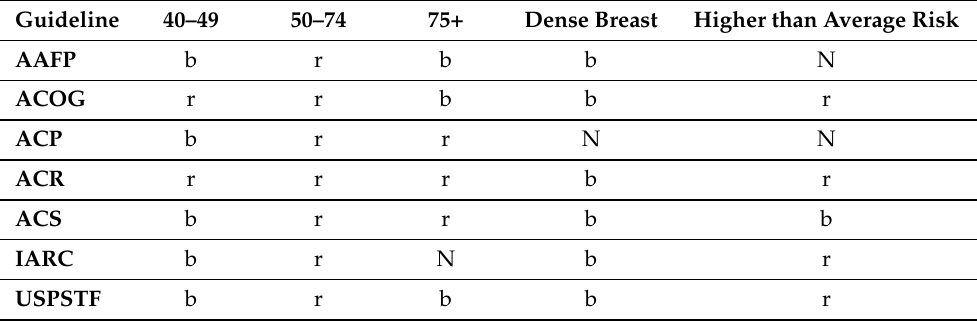
Figure 2. The method of comparing concepts in full documents and recommendations contained in summaries. Note the difference in representations: the document are represented by a large number of high-dimensional (200) vectors with real valued features, whereas the disagreement representations can be low-dimensional vectors with discrete features (e.g., five-dimensional for the breast cancer screening guidelines). Our exposition will roughly follow the left-to-right order of this figure, using the breast cancer screening guidelines as the motivating example. Table 1. The table shows recommendations as follows: N—no recommendation; b—both patient and doctor, shared decision; r—recommending